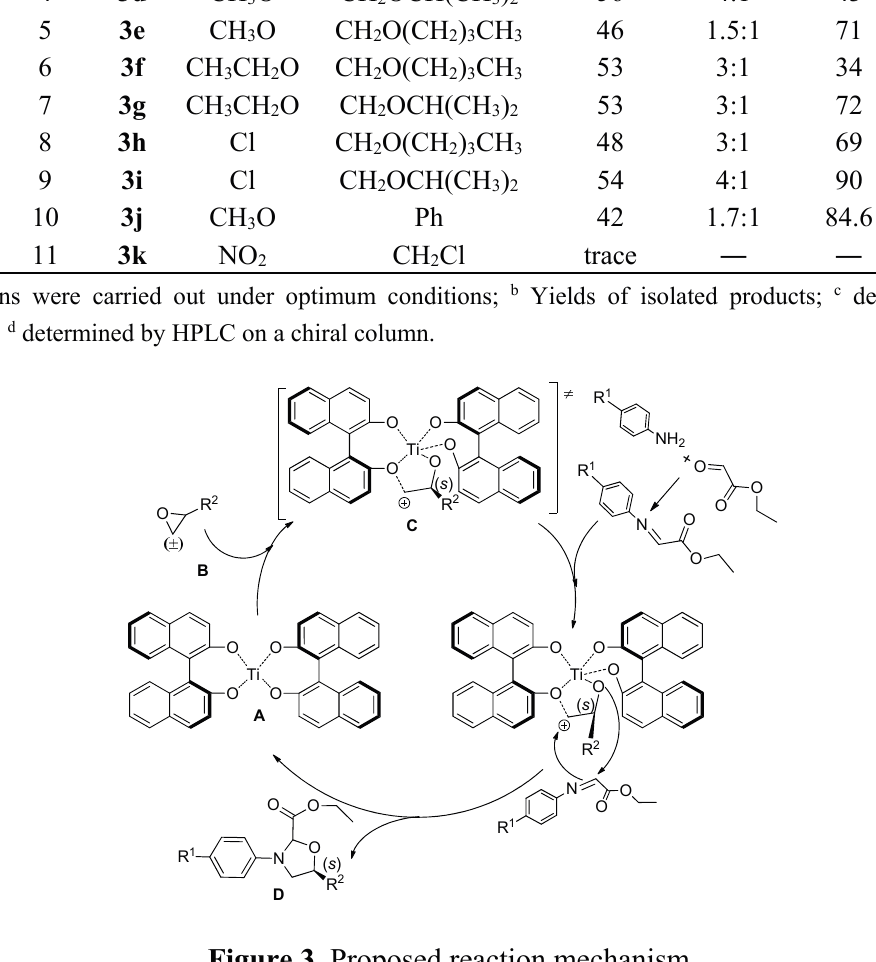
Figure 3. Proposed reaction